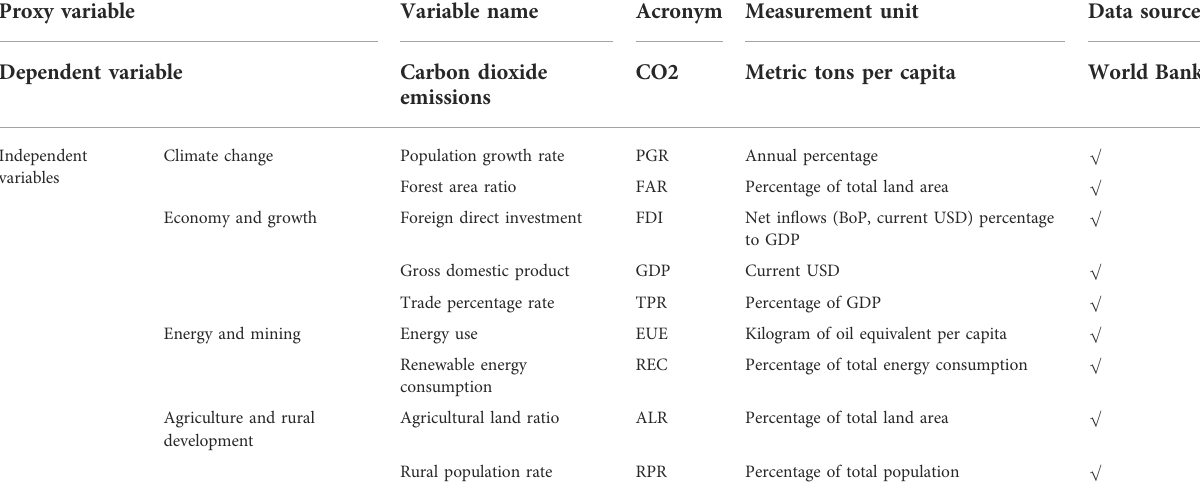
TABLE 1 Theoretical